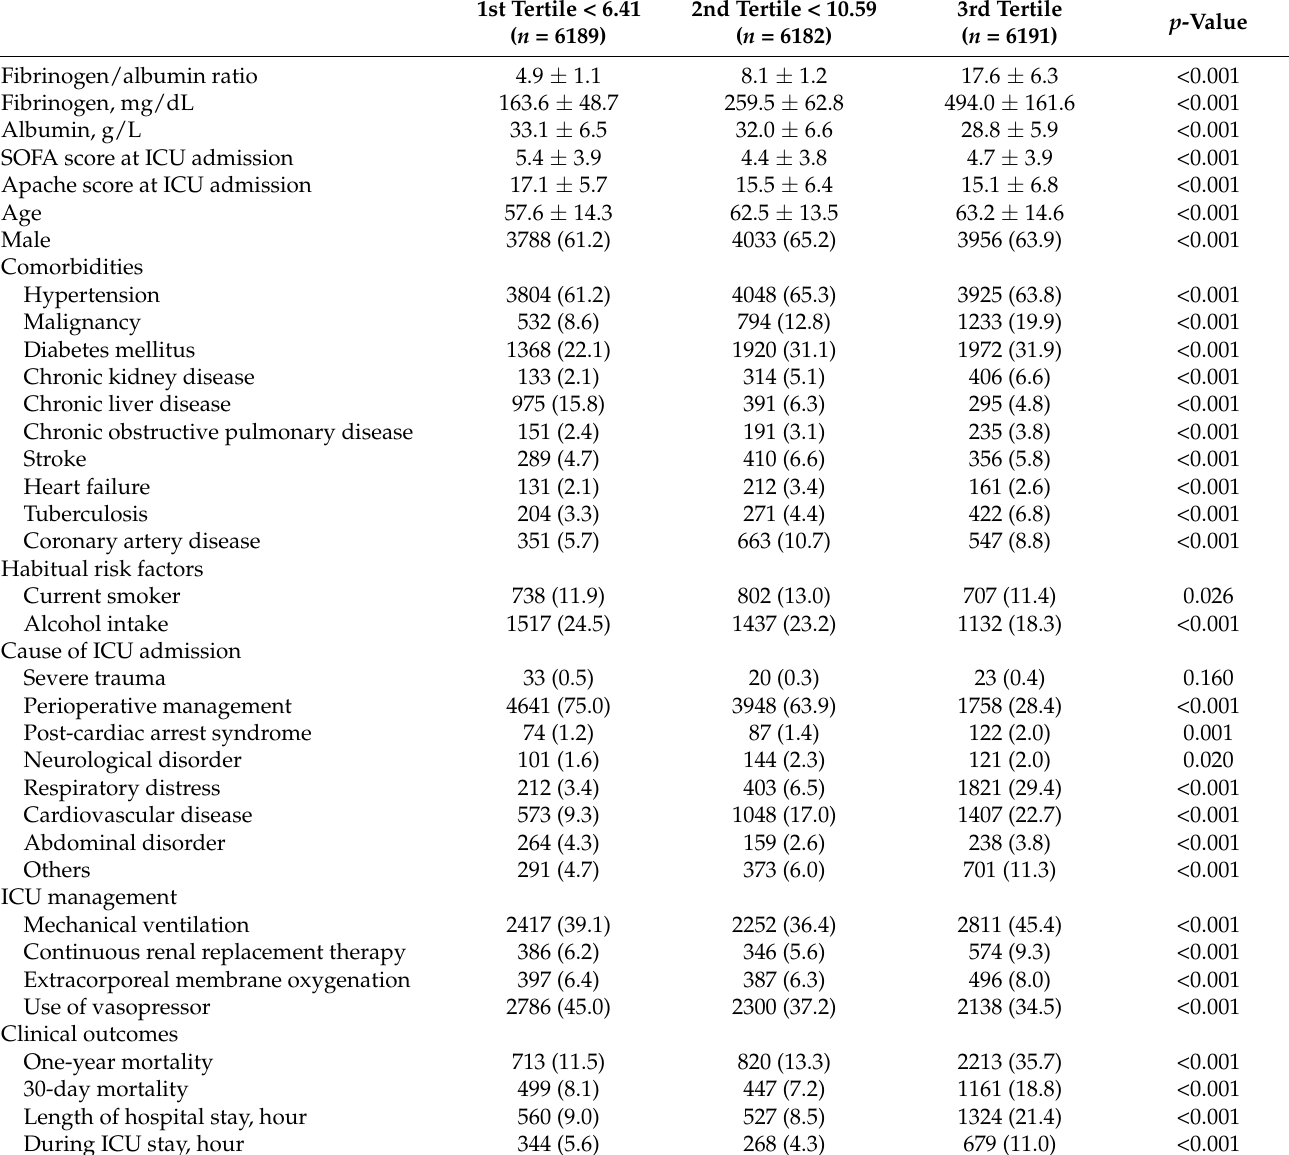
Table 1. Baseline characteristics and mortalities according to tertile values of fibrinogen/albumin